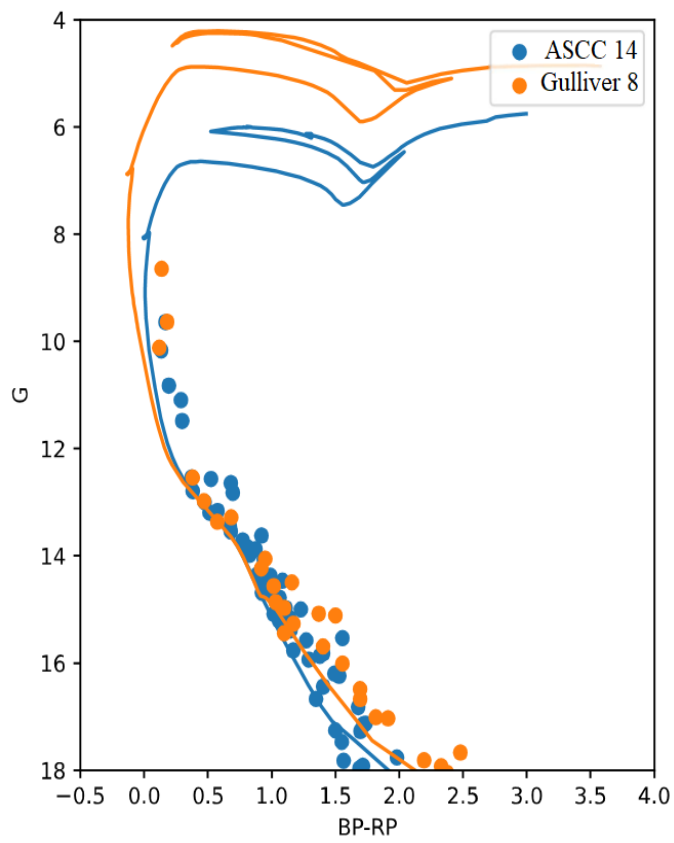
Figure 2. Overlapping CMDs and fitting isochrones of ASCC 14 and Gulliver 8, obtained using Gaia EDR3 photometry. The constraints are defined in Table 1.